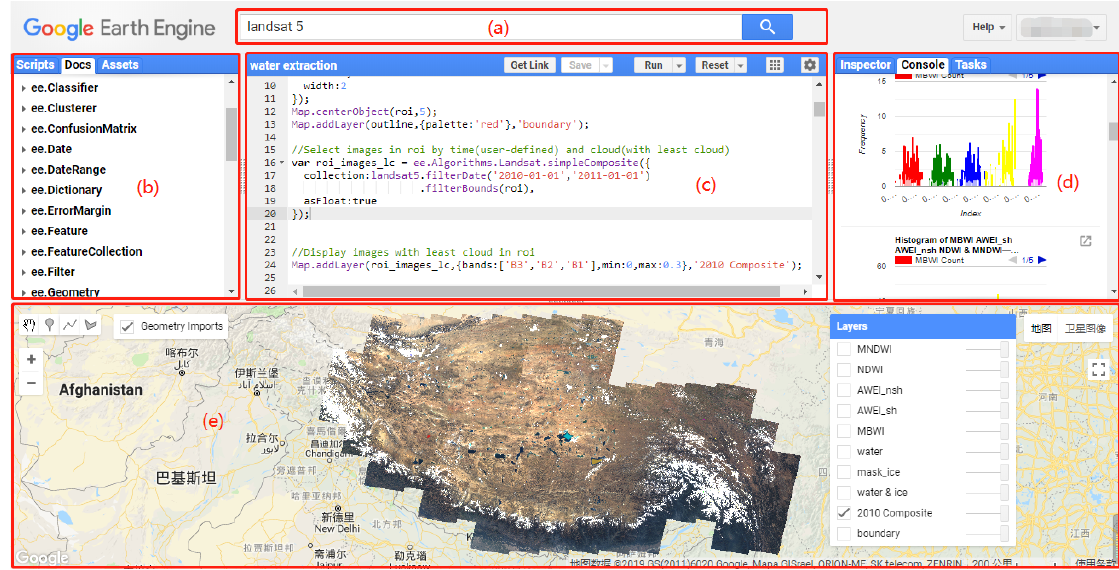
Figure 2. The interface of GEE: (a) is for data retrieval; (b) is for code preservation, document query and resource uploading; (c) is for code editing; (d) is for information query, result outputing, task downloading and running resource displaying; (e) is for layer